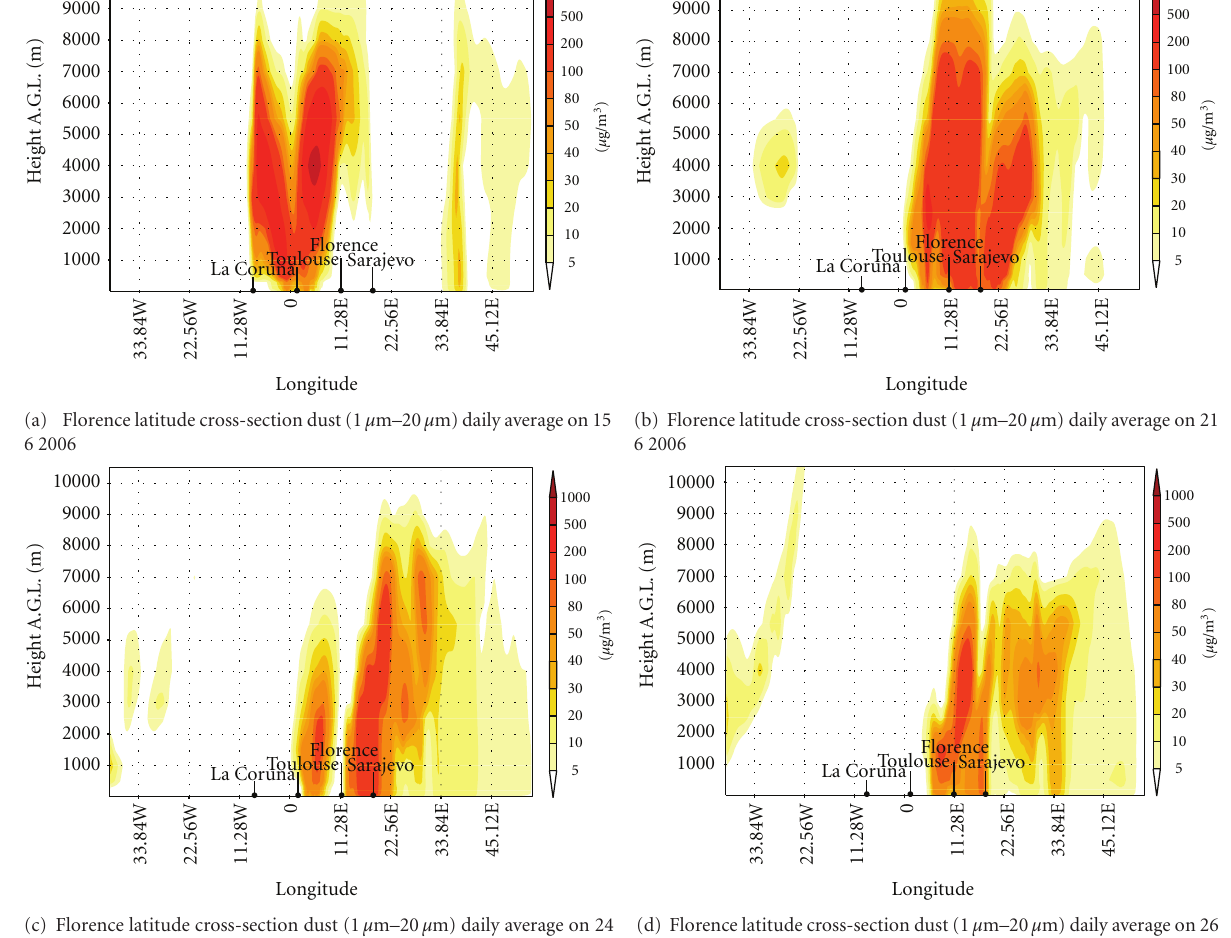
Figure 7: Latitude cross-section at 43.78 ◦ N of the daily average of dust concentration for 15th of June (a), 21st of June (b), 24th of June (c) and 26th of June 2006